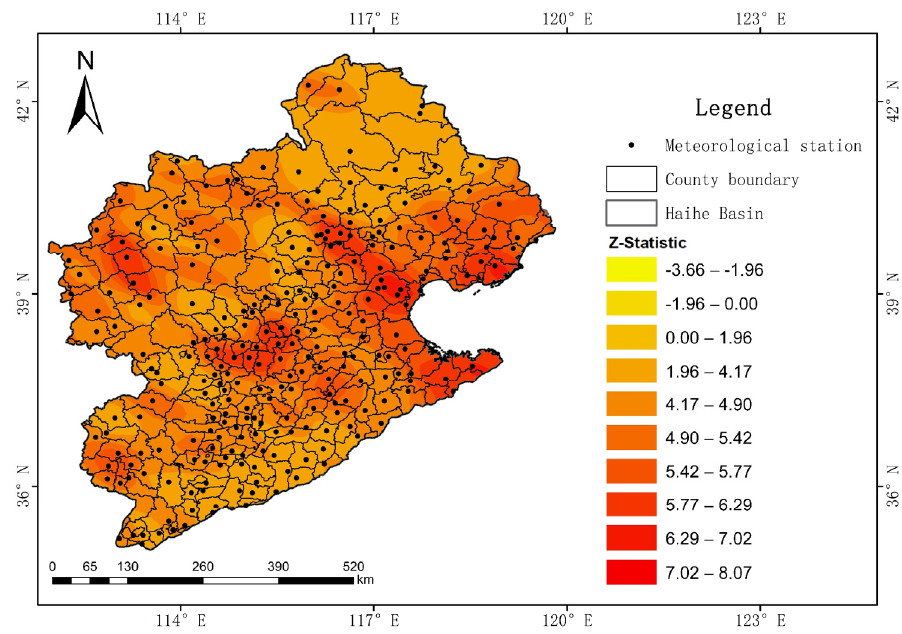
Figure 3. Spatial distribution of the significance level of annual mean